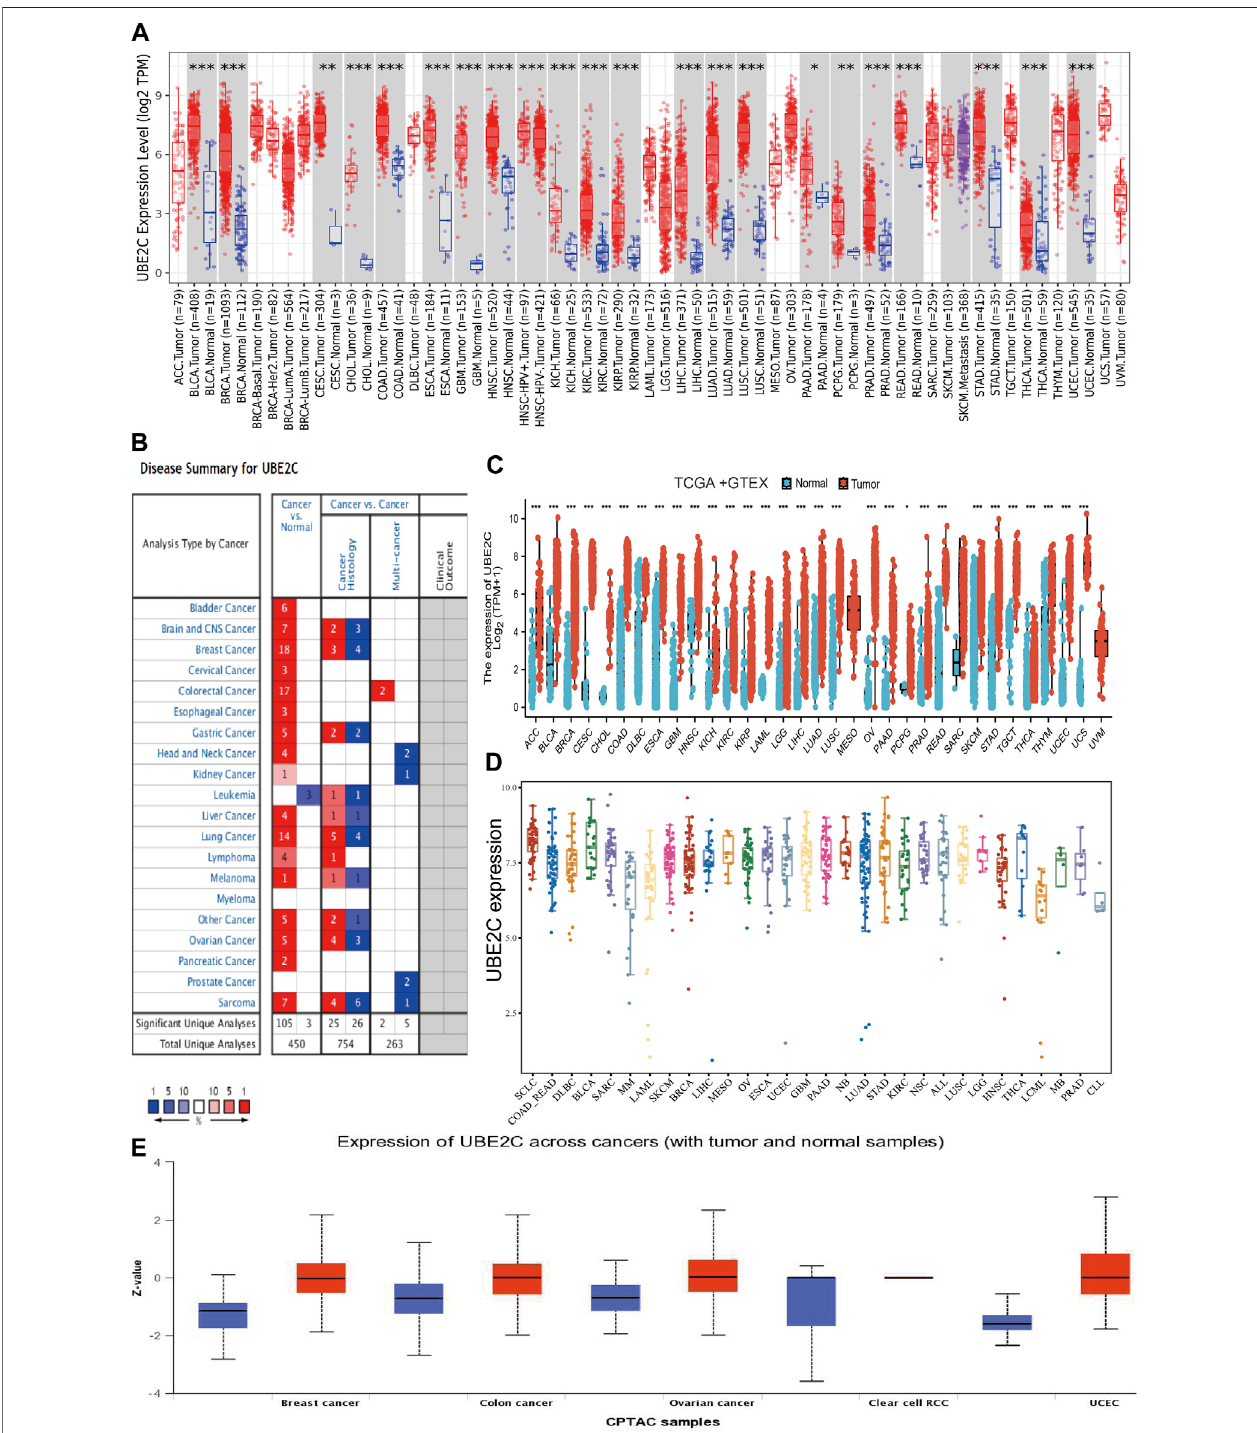
FIGURE1| Expressionanalysisfor UBE2Cinhumancancers. (A) The expression ofUBE2Cinpan-cancer analysisbytheTIMERdatabase. (B) Theexpression of UBE2Cinpan-canceranalysisbytheOncominedatabase. (C) TheexpressionofUBE2Cinpan-cancerexaminedbytheGEPIAdatabase. (D) TheexpressionofUBE2C in diverse cancer cell lines examines by the CCLE database. (E) The protein expression of UBE2C in pan-cancer analysis by the UALCAN database.